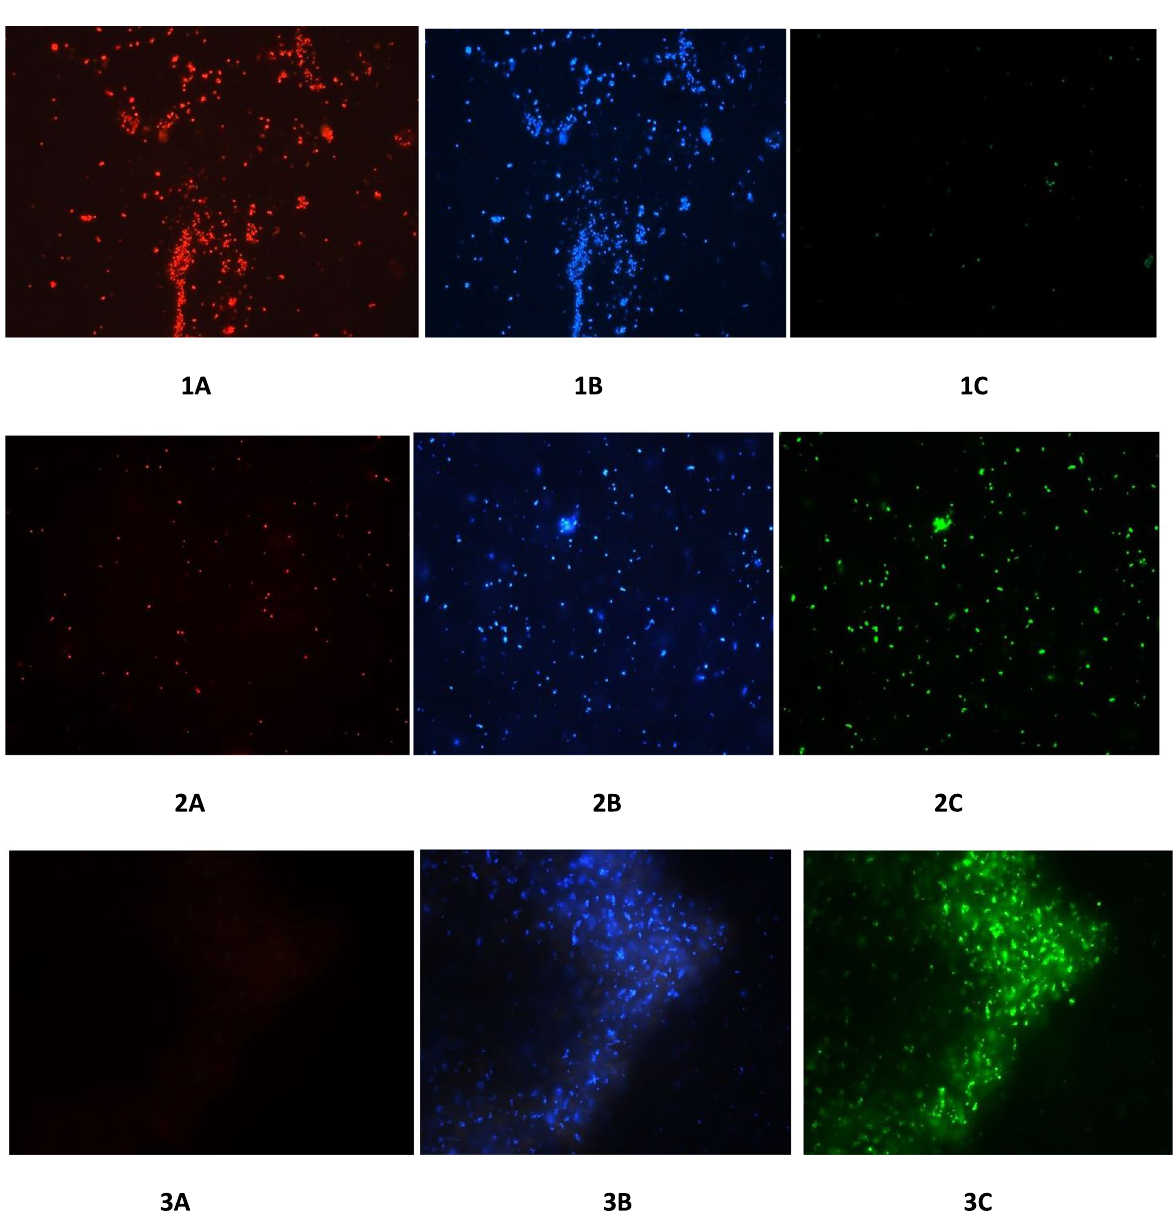
Fig. 14 Triple staining images of expression host, E. coli during recombinant expression of Pp -ALF 1A-C: 0 th h- CTC, DAPI, and FITC-stained cells 2A–C: 2 nd h 3A–C: 6 th